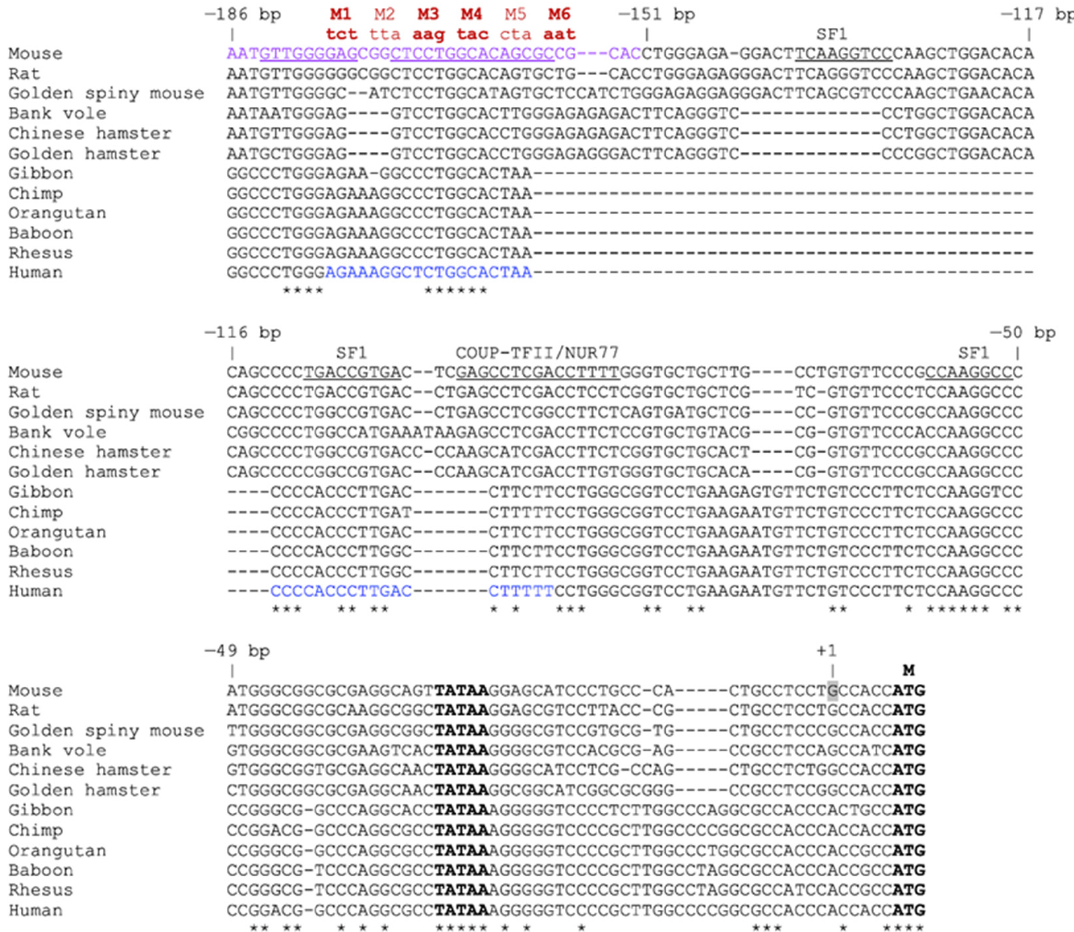
Figure 8. Alignment of the proximal Insl3 gene promoter from different species. The sequences of the proximal Insl3 promoter ( − 186 bp to the ATG of the mouse promoter) from various species indicated on the left were aligned using Clustal Omega multiple sequence alignment tool. The numbering corresponds to the position in the mouse Insl3 promoter. The 35-bp region important for mouse Insl3 promoter activity identified in this study is shown in purple. The mutations generated in the 35-bp region are shown in red (M1–M6); the bolded ones (M1, M3, M4, M6) were unable to compete the binding in EMSA. The underlined sequences correspond to potential binding sites for CREB, NF- κ B, AP1, AP2, and C/EBP family members. The sequence shown in blue corresponds to an approximately 40-bp region ( − 132 and − 93 bp) previously identified as important for the activity of the human INSL3 promoter [18]. The positions of previously identified binding sites for transcription factors SF1, COUP-TFII, and NUR77 are shown. The TATA-box, transcription start site (+1), and ATG (M) are also indicated. An asterisk indicates a nucleotide conserved across all 12 species.